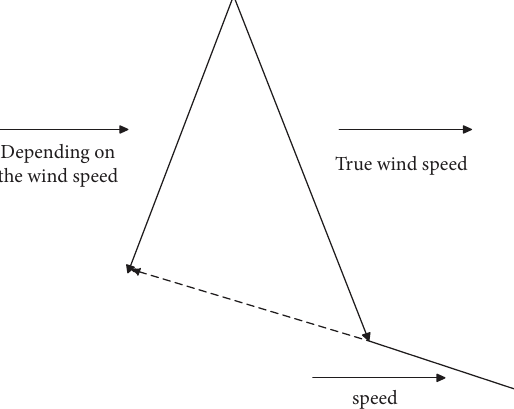
Figure 2: Vector relationship between true wind speed and apparent wind